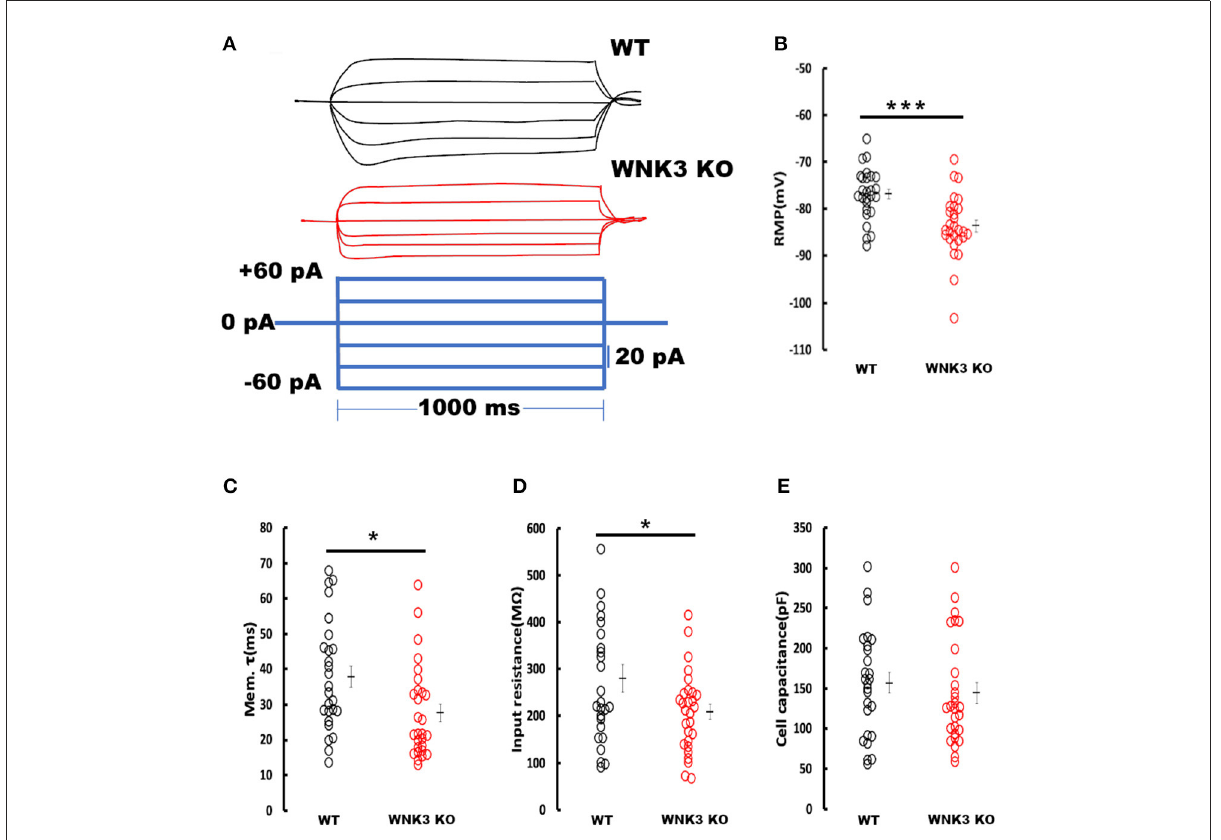
FIGURE3 Enhanced resting membrane conductance in WNK3 KO neurons alter passive membrane properties. (A) Representative current-clamp recordings at small hyperpolarizing and depolarizing current steps. Step current injections of 1 20pA starting from − 60pA to + 40pA (lower panel, blue current step) and corresponding membrane voltage changes recorded from WT (upper panel, black traces) and WNK3 KO (middle panel, red traces) neurons are illustrated. The duration of the step pulse was 1,000ms. (B) Quantitative analysis of RMP values indicate significantly hyperpolarized membrane potential in WNK3 KO neurons (WT = − 76.81 ± 1.07mV, n = 26 cells, 7 mice; WNK3 KO = − 83.60 ± 1.26mV, n = 28 cells, 7 mice; t- test *** P < 0.001). (C) Comparison of membrane time constant ( τ m ) values are significantly decreased (WT = 37.93 ± 3.05ms; WNK3 KO = 27.68 ± 2.48ms; Mann–Whitney U test , * P < 0.05). (D) Quantitative analysis of input resistance of layer V pyramidal neurons from the mPFC. The input resistance of pyramidal neurons is significantly reduced in the WNK3 KO group (WT = 280.4 ± 29.15 M Ω ; WNK3 KO = 209.03 ± 16.02 M Ω ; t- test , * P < 0.05). (E) Plots of calculated cell capacitance values were similar in WT and WNK3 KO neurons (WT = 156.86 ± 12.98 pF; WNK3 KO = 144.31 ± 12.39 pF; Mann–Whitney U test , ns ). Individual data points are plotted as WT (black open circles) and WNK3 KO (red open circles). The mean values are indicated with solid bars next to the data points. Error bars represent